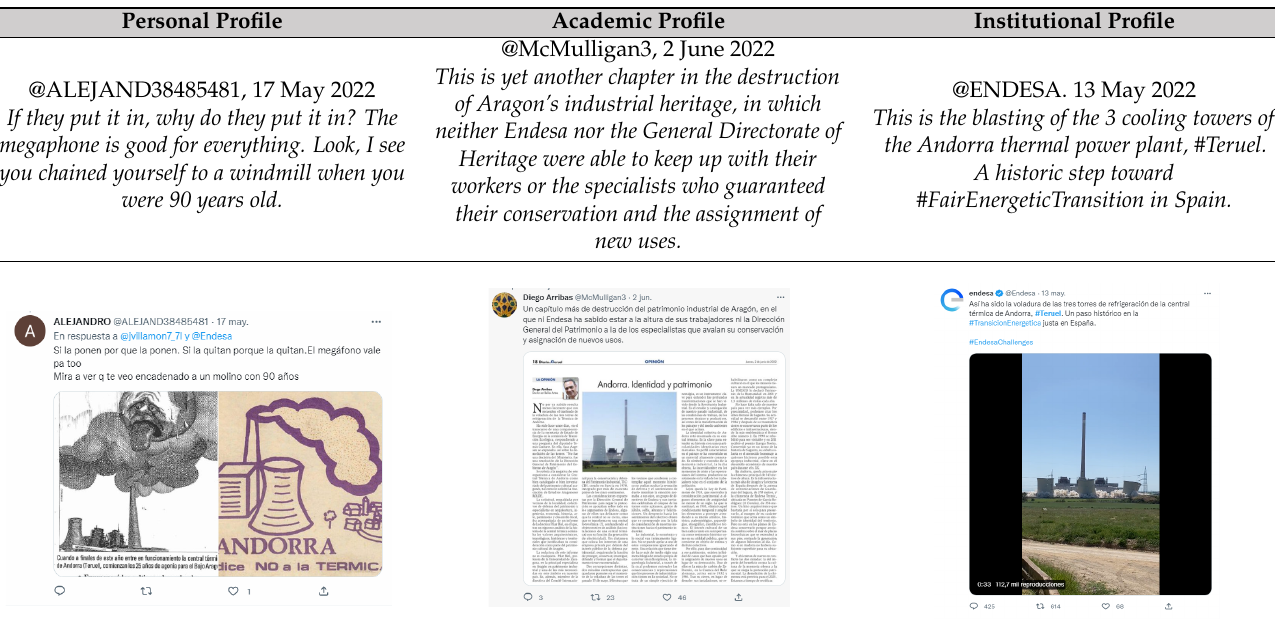
Table 5. Analysis of public publications (tweets) from